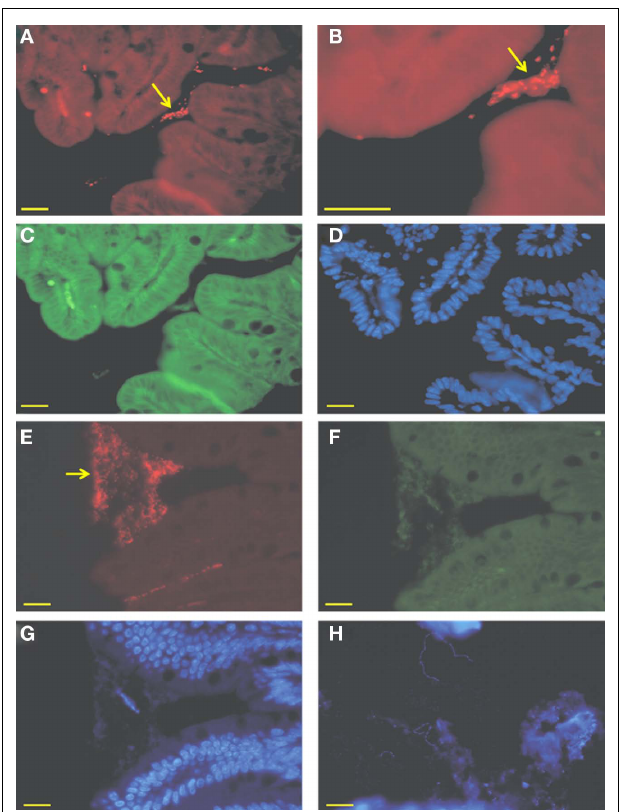
FIGURE 1 | Micrograph of intestinal biopsy samples from mono-colonized mice. (A–D) Ileal biopsies and colonic (E–G) of mice mono-associated with A. muciniphila . Cells were hybridized with the Cy3-labeled MUC-1437, specifically staining A. muciniphila . (A,B,E) , aggregates of A. muciniphila cells are zoomed and closely associated with the epithelial cells (B) , FITC-labeled EUB-338, targeting all bacteria (C,F) and a DAPI staining (D,G) . Arrows indicate aggregates of A. muciniphila . (H) Cecal biopsy from L. plantarum mono-associated mouse stained with DAPI. Bar represents 10 μ m.